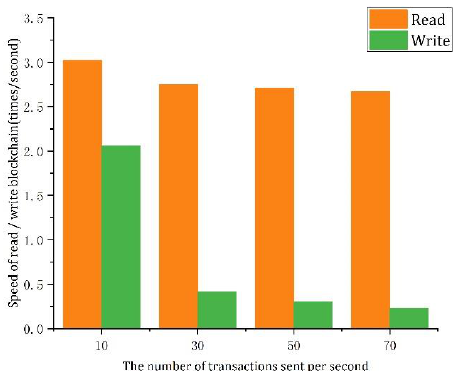
Figure 7. Read/write blockchain speed for 5 peer nodes.